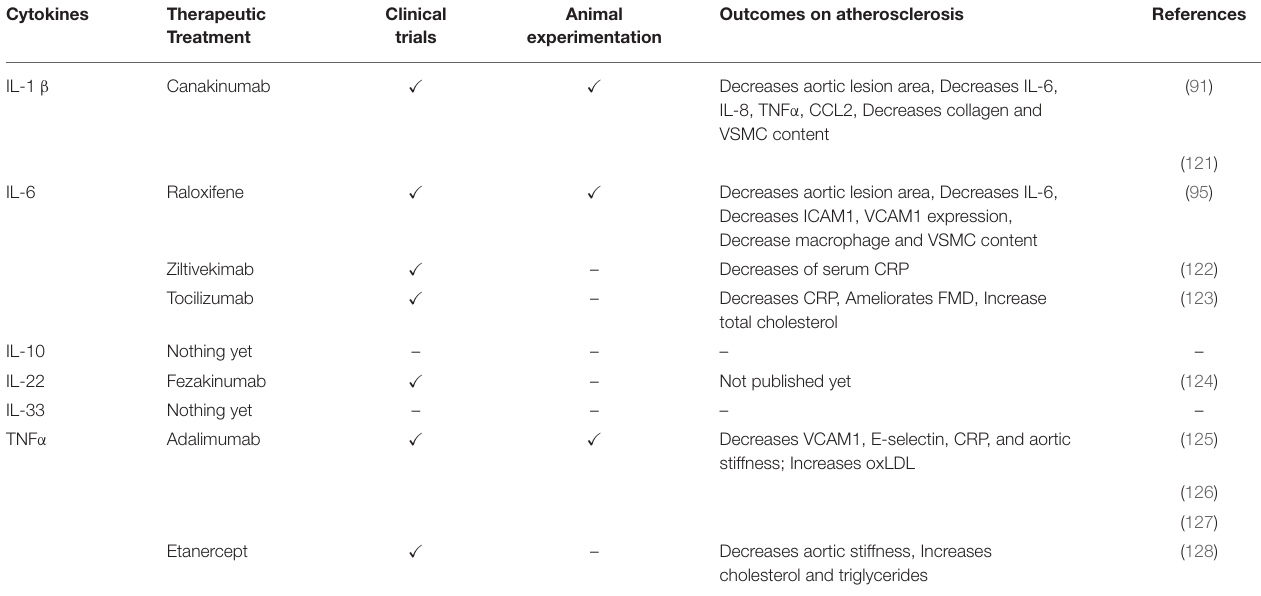
TABLE 4 | Targeting cytokines as therapeutic treatments in vascular remodeling and CVD.